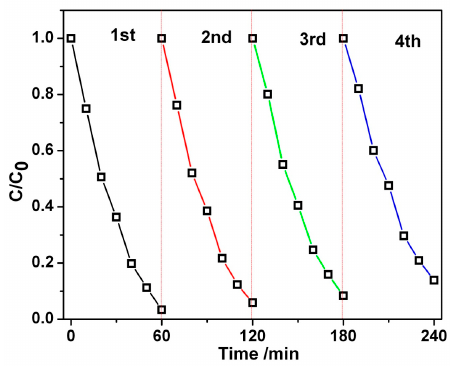
Figure 8. Photodegradation of RhB solution with a composite photocatalyst B/D-70% in different testing cycles.